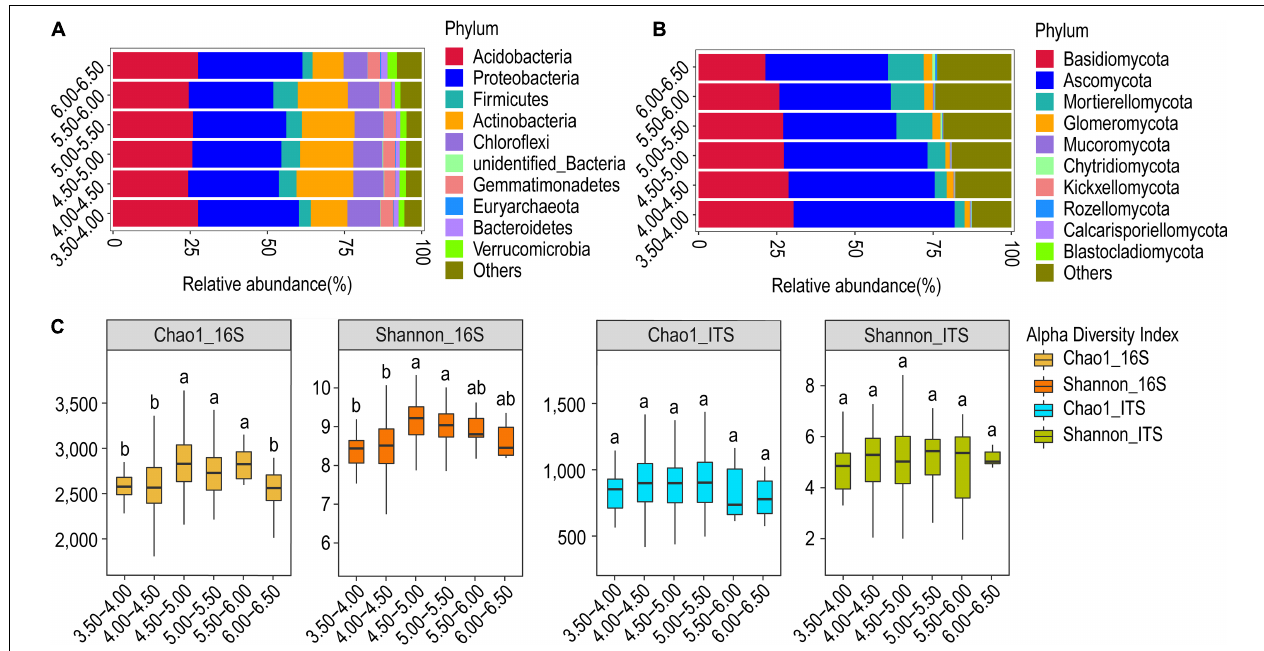
FIGURE 2 | Relative abundance and α -diversity indices of soil bacterial and fungal communities in different pH gradient groups. (A) Relative abundance of bacteria at the phylum classification level (first 10 bacterial phylum, same below); (B) relative abundance of fungi at the phylum classification level (first 10 fungi phylum, same below); (C) Chao1 and Shannon indices of bacteria and fungi. Different lowercase letters indicate significant differences between subgroups ( p < 0.05) (same